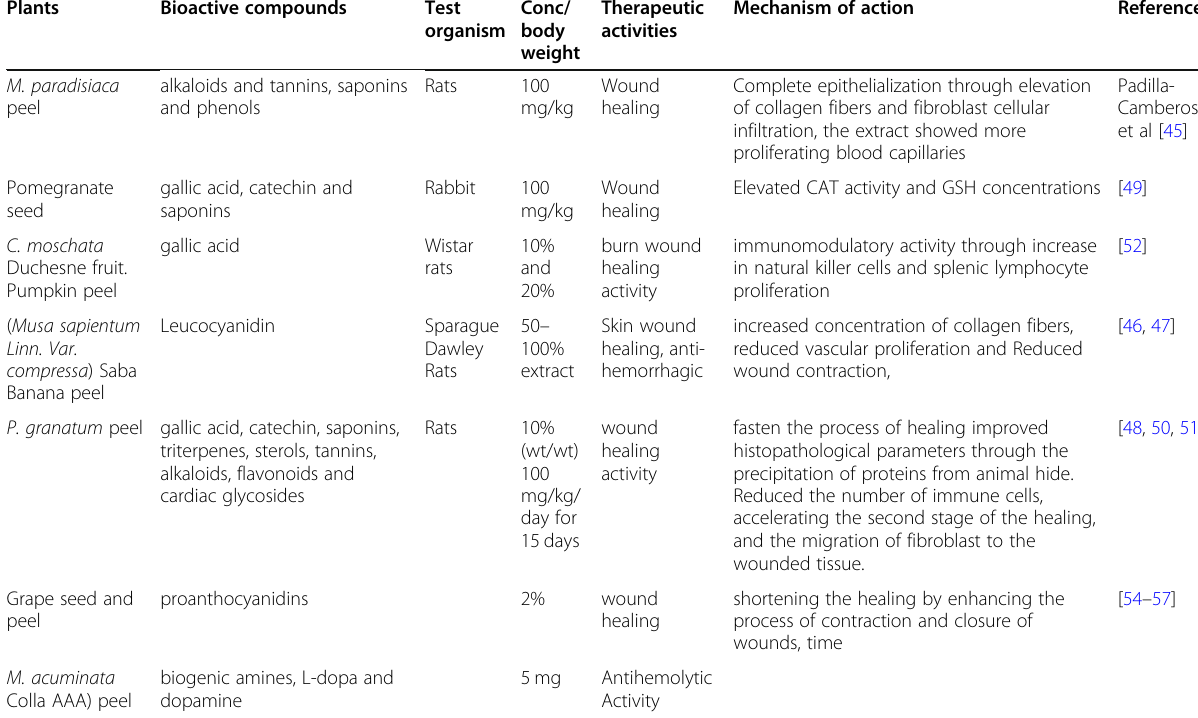
Table 2 Wound healing properties of some peels and seed extracts